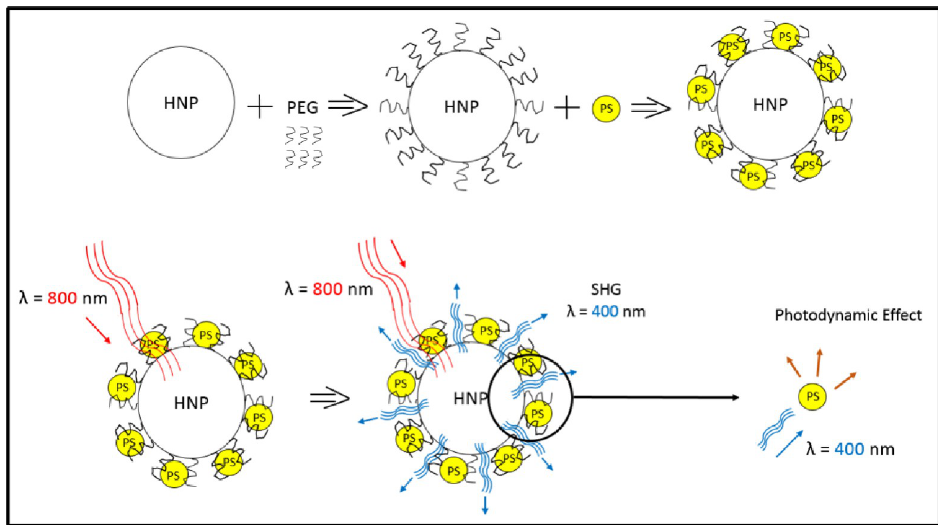
Fig 1. Schematic of photodynamic effect responsive to NIR (Near-infrared) light involving Harmonic Nanoparticle conjugated to Photosensitizer (HNP+PS) using Polyethylene Glycol